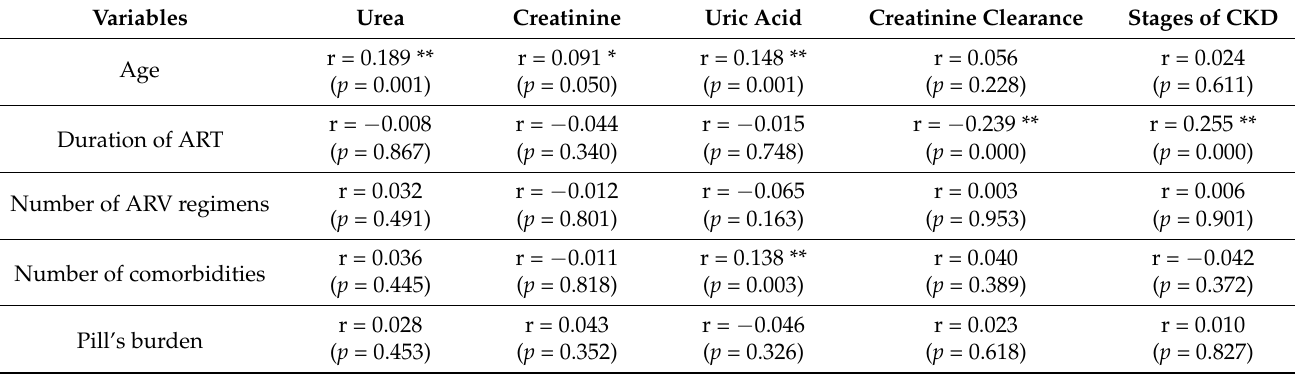
Table 12. Pearson correlation on the risk of impaired renal function in HIV positive patients (N = 462)